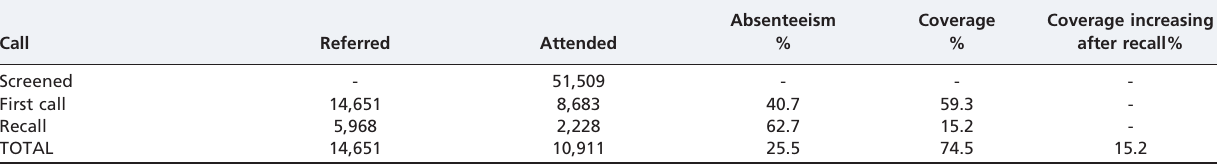
Table 1 - Coverage of ophthalmological service – Eye-to-Eye Campaign - Guarulhos, 2006 and 2007. Call